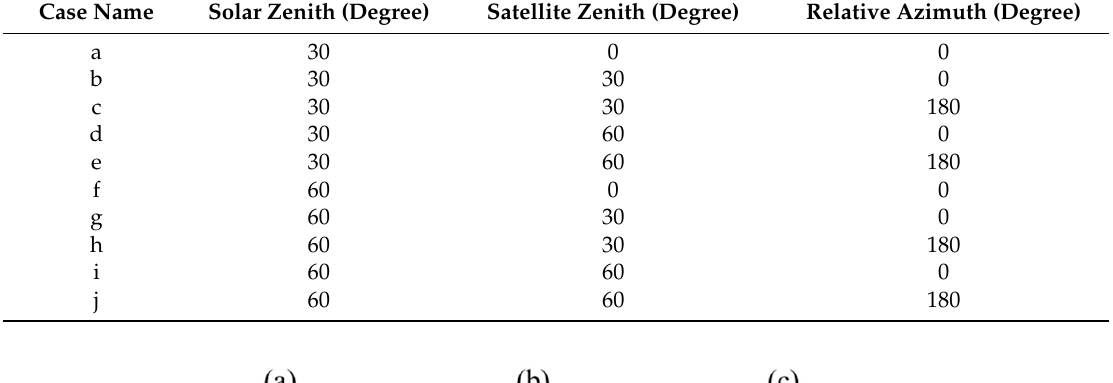
Table 3. Description of the set of different geometrical conditions used to simulate the relationship between TANSO-CAI TOA reflectance and AOD with different surface conditions.